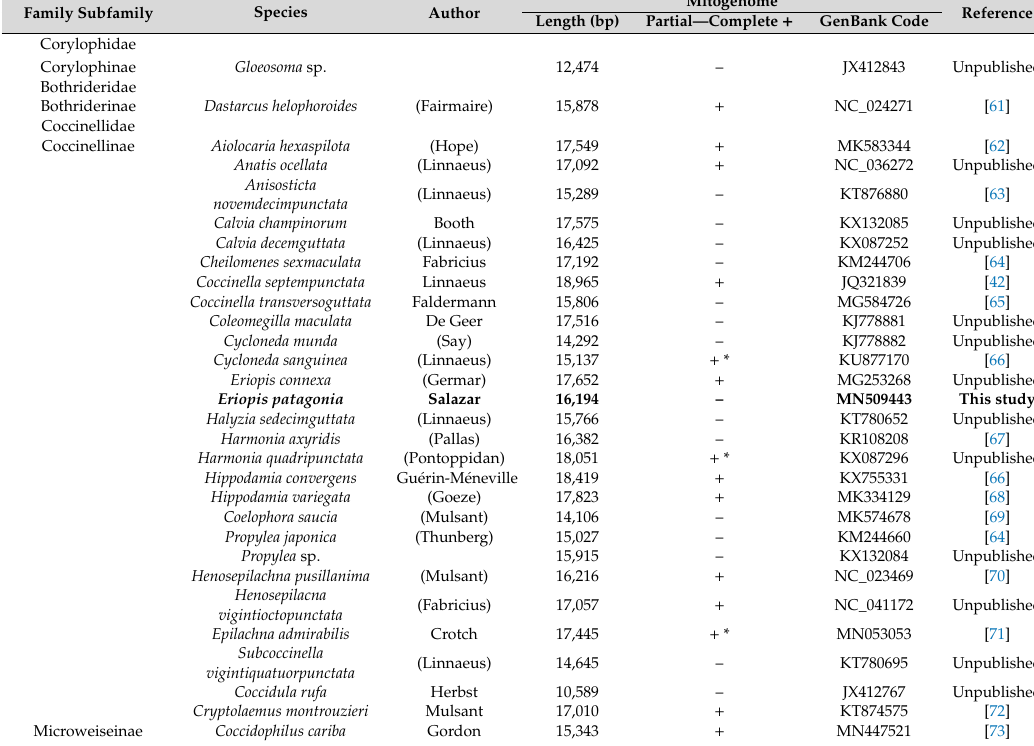
Table 1. Species of Coccinelloidea used in the phylogenetic analysis. Respective GenBank accession numbers of the mitochondrial genomes and references are